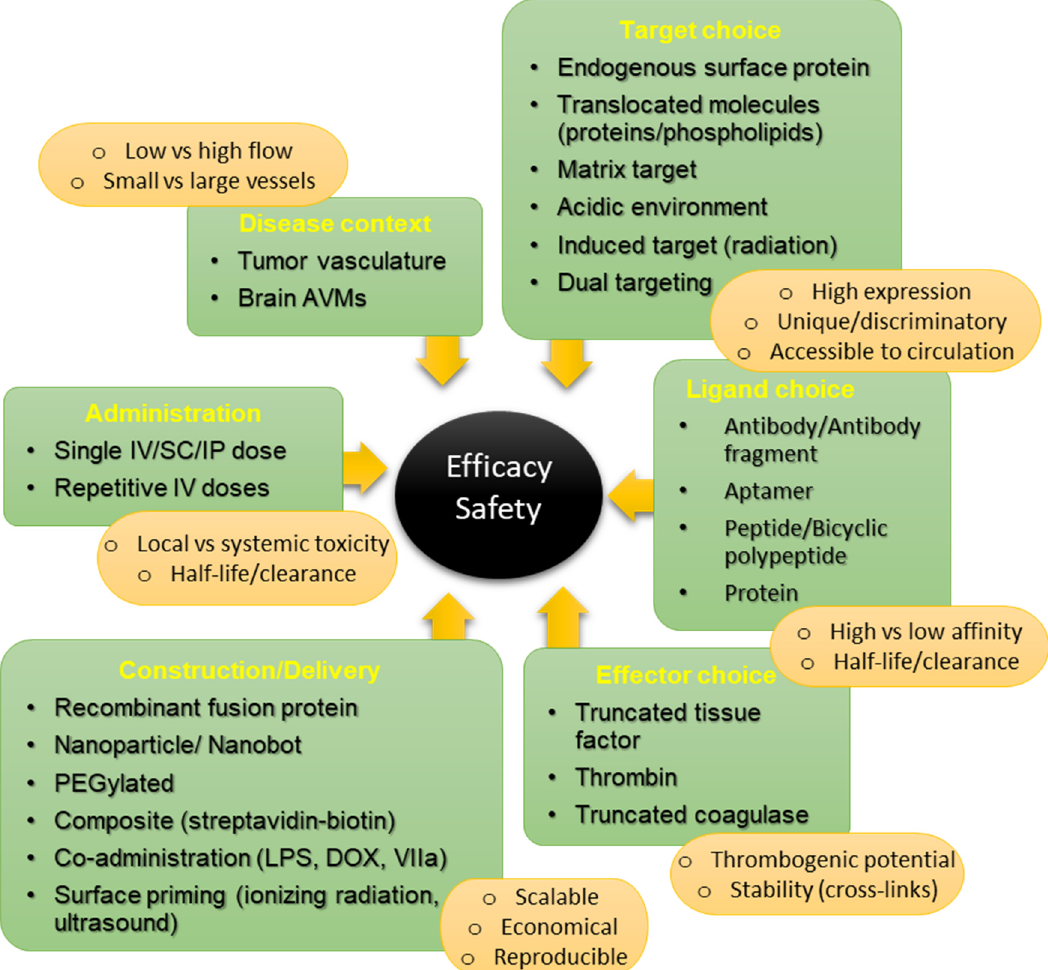
Figure 2. Considerations in coaguligand development that influence efficacy and safety. In the field of vascular targeting with precision thrombosis, many factors must be considered in the choice of coaguligands that achieve substantive efficacy without compromising safety in each disease context. Many endogenous targets have been investigated for selectivity in the context of solid tumor targeting, but expression levels are still considered a primary limiting factor for complete tumor ablation. Ligand affinity, as well as rate of clearance, may influence binding under high or low flow and subsequent efficacy within the therapeutic window. In particular, the choice of effector may play a significant role in efficacy for large versus small vessels, depending on individual thrombogenic potential. This must be balanced with stability of clot formation, and any risk of emboli or disseminated intravascular coagulation. Novel approaches to coaguligand construction or delivery that increase effector activity without exceeding toxic thresholds continue to be investigated. [Original figure, created by F. Faqihi].